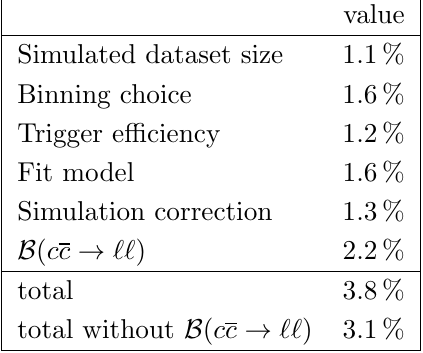
Table 3 . Relative systematic uncertainties on the ratio of branching fractions. using a weighted average